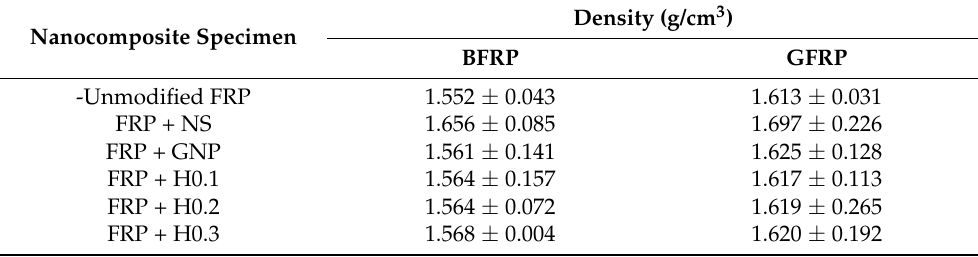
Table 2. Density of FRP Nanocomposite System Measured by Archimedes